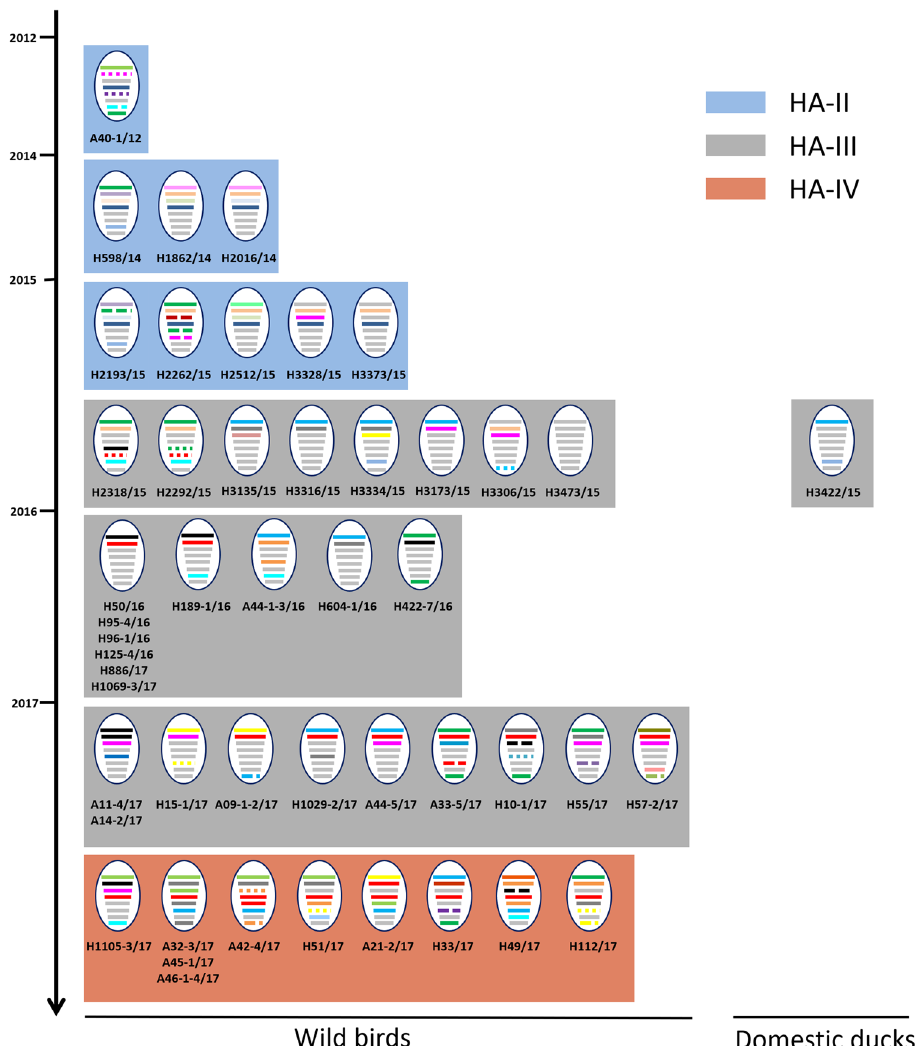
Figure 2. Genotypes of H5 LPAIVs isolated in South Korea from 2012 to 2017. The eight gene segments of avian influenza virus (from top to bottom, PB2, PB1, PA, HA, NP, NA, MP, and NS) are indicated by horizontal bars. The colors of the gene-segment bars denote different viral lineages. The timescale of virus isolation is indicated on the vertical scale. Labels below each genotype are identifiers for corresponding viruses characterized in this